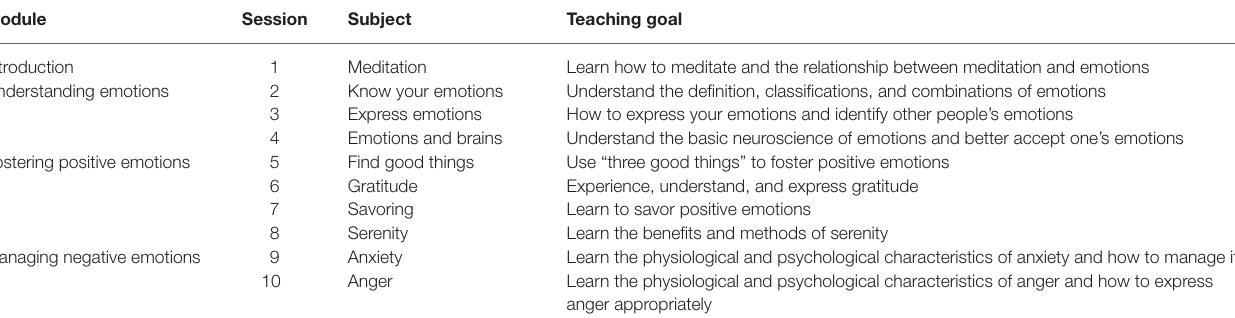
TABLE 1 | Outline of the positive education program. Module Session